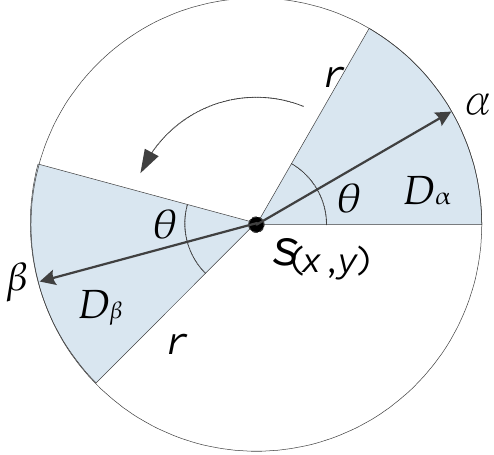
Figure 1. Directional sensing for a rotatable sensor.